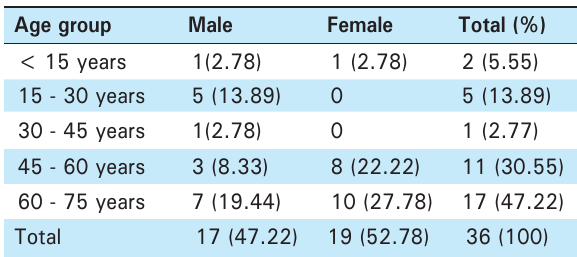
Table 1. Age and gender distribution of